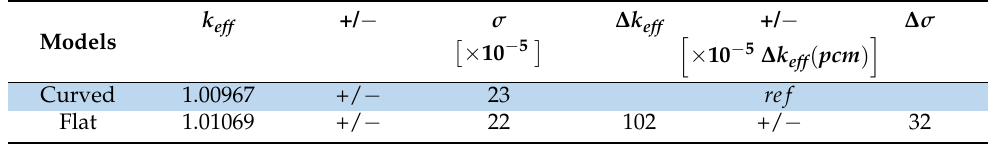
Table 3. k ef f results of the curved and flat core. Table 3. 𝑘 (cid:3032)(cid:3033)(cid:3033) results of the curved and fl at core.